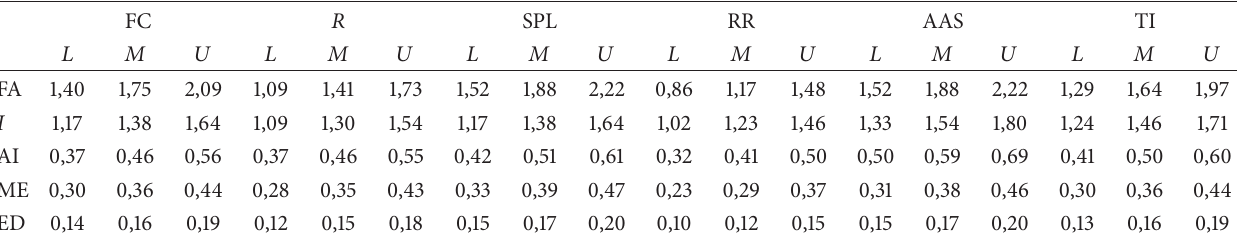
Table 13: Values of 𝑊 𝑇 .